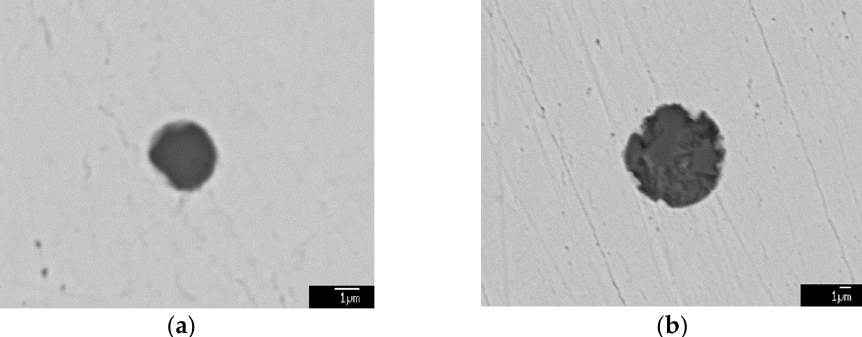
Figure 9. Two morphology types of CaO-Al 2 O 3 -SiO 2 inclusions. ( a ) CaO-Al 2 O 3 -SiO 2 , ( b ) CaO-SiO 2 . Table 3. Chemical compositions of CaO-Al 2 O 3 -SiO 2 inclusions.